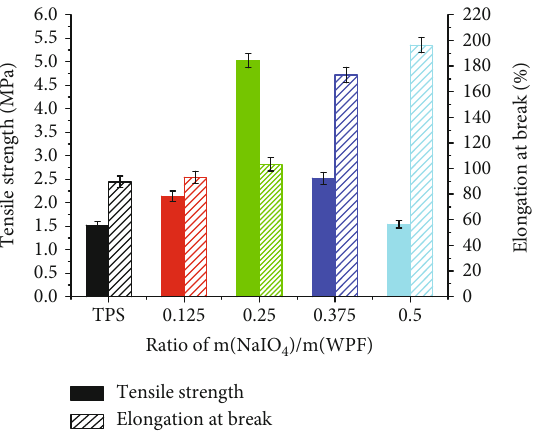
Figure 6: E ff ect of the oxidation degree of OWPF on tensile strength and elongation at break of OWPF/TPS